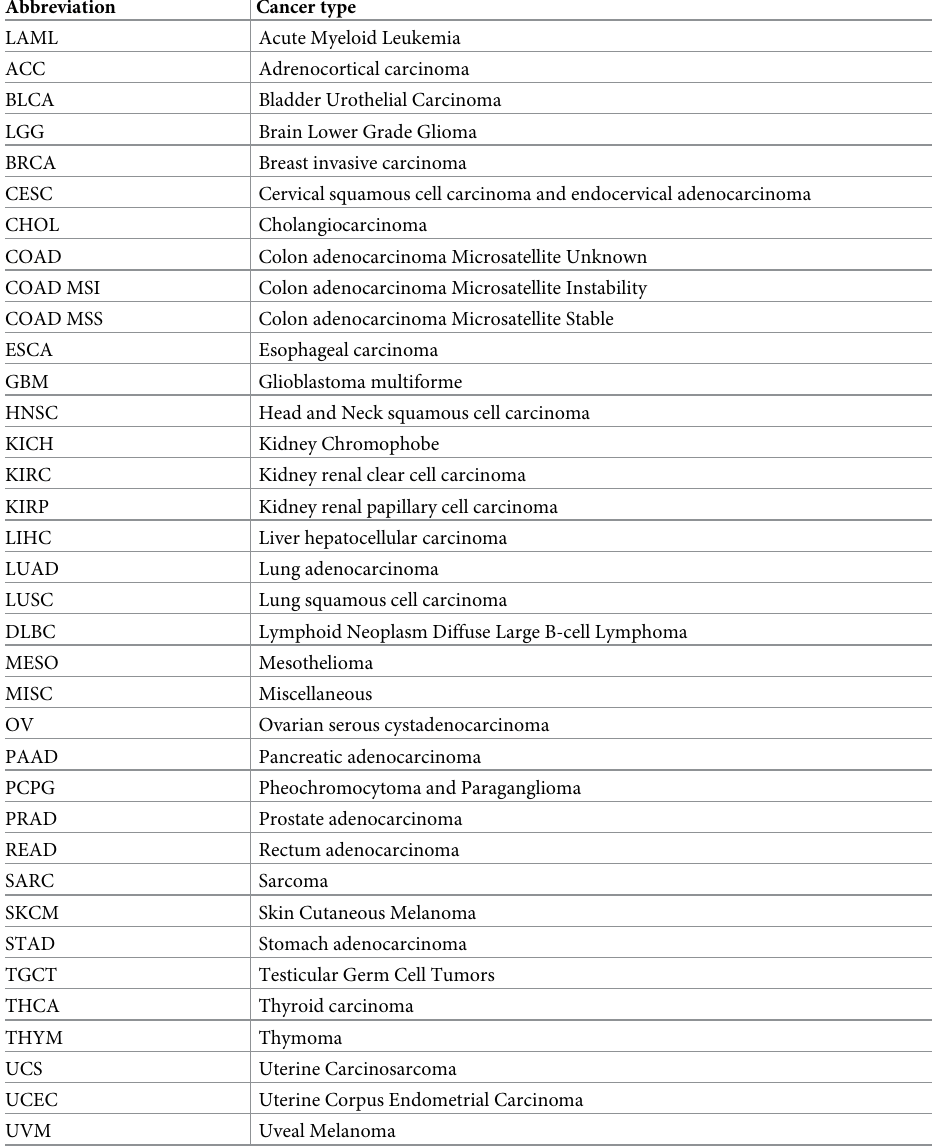
Table 1. Cancer type abbreviations from the Cancer Genome